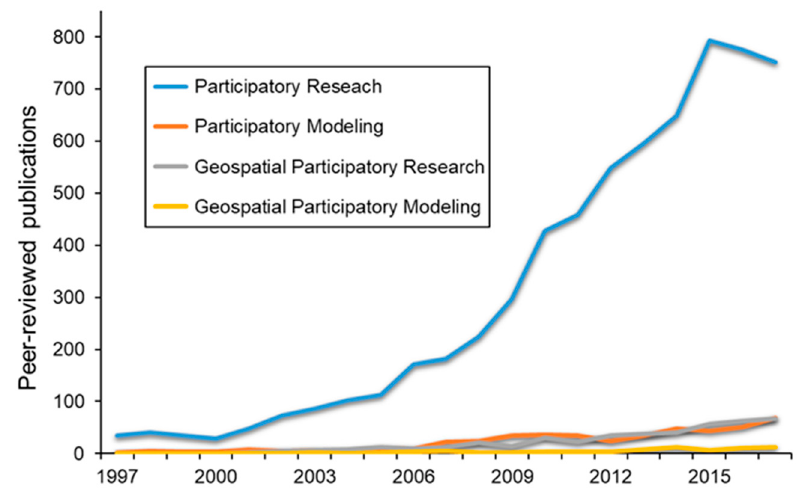
Figure 1. Using the search terms “participatory research”, “participatory model*”, “geospatial participatory research”, and “geospatial participatory model*,” we found in a Web of Science search that only 8.4% percent of participatory research studies have used geospatial approaches, including static maps, geographic information systems, or other visuals of landscapes (446 of 5321 studies, excluding those in the medical sciences), and only 1.5% of participatory research studies have used geospatial modeling (78 of 5321 studies). “*” search operator includes model, models, modeling, and modelling.